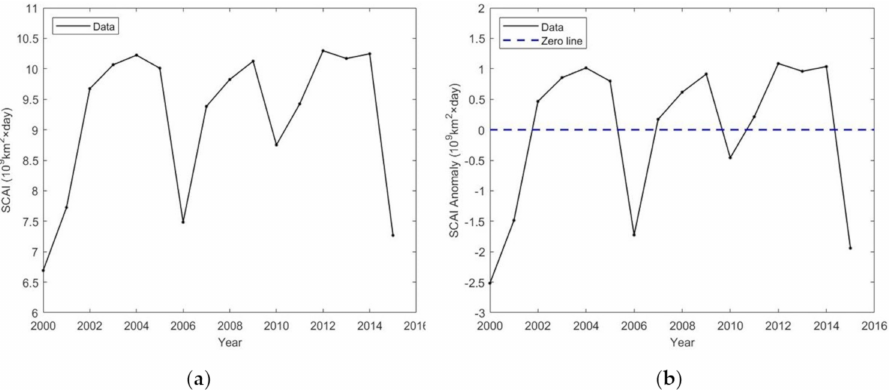
Figure 7. Inter-annual variation of snow cover area index (SCAI) in the study area from 2000 to 2016: ( a ) SCAI variation, and ( b ) SCAI anomaly,